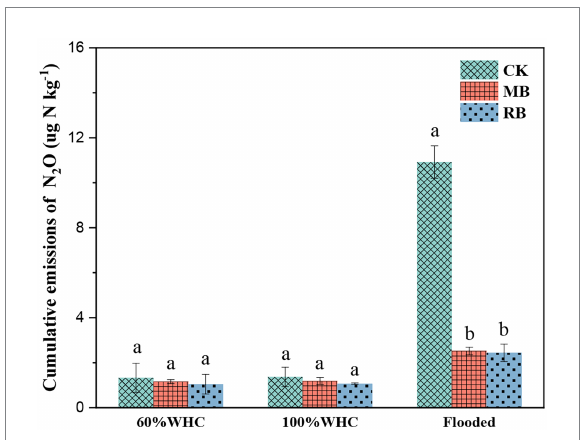
FIGURE 3 Cumulative N 2 O emissions with biochar amendments during the thawing period. (CK: control; MB: maize straw biochar; RB: rice straw biochar; and a and b indicate significant differences among